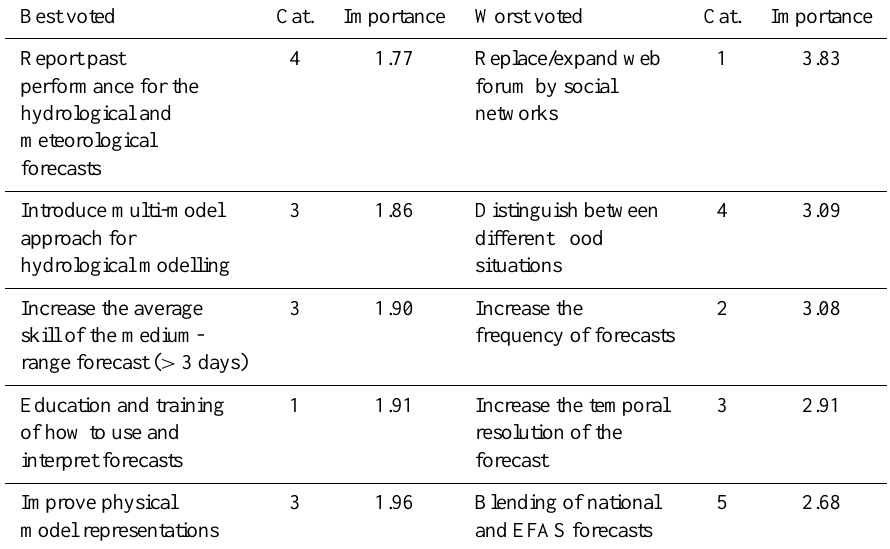
Table 4. The five most popular and least popular priorities from the survey. Best voted